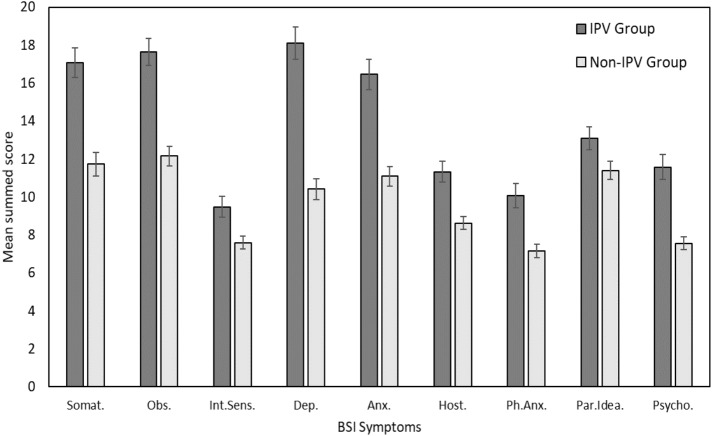
Mean average summed scores across BSI symptoms for women victims of IPV (IPV Group) and a control group (Non-IPV Group).Error bars correspond to ±1 standard error. Somat., Somatization; Obs., Obsession-Compulsion; Int. Sens., Interpersonal Sensitivity; Dep., Depression; Anx., Anxiety; Host., Hostility; Ph.Anx., Phobic Anxiety; Par.Idea., Paranoid Ideology; Psycho., Psychoticism.